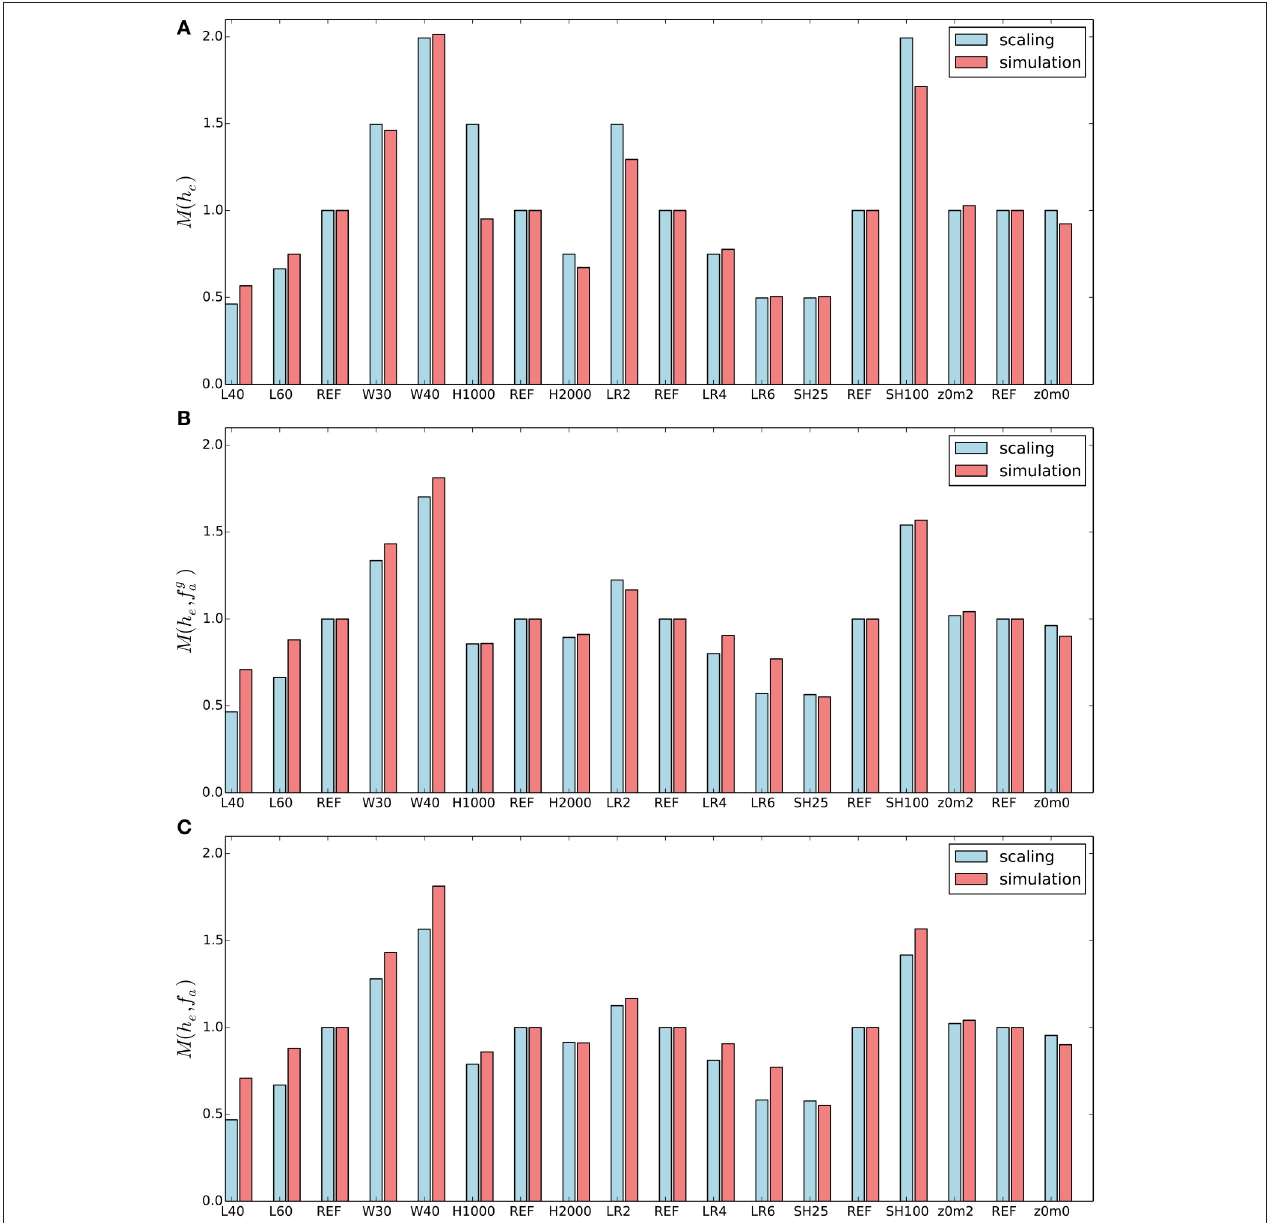
FIGURE 8 | Scaling the along-valley mass flux M : comparison of different a-priori estimates of M with the corresponding diagnosed value from the numerical simulations. (A) Basic approximation M = M ( h c ) , (B) improved estimate with M = M ( h e , f g a ) , (C) improved estimate with M = M ( h e , f a ) . The former estimate is compared to the simulated along-valley flux up to ridge height, the latter two estimates are compared to the total simulated up-valley flux, that is to the height h e